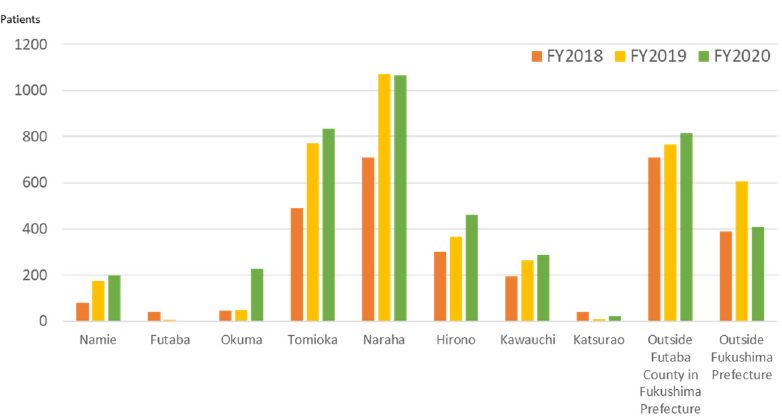
Figure 9. Annual number of patients treated at Futaba Medical Center by municipalities of residence, 2018–2020.